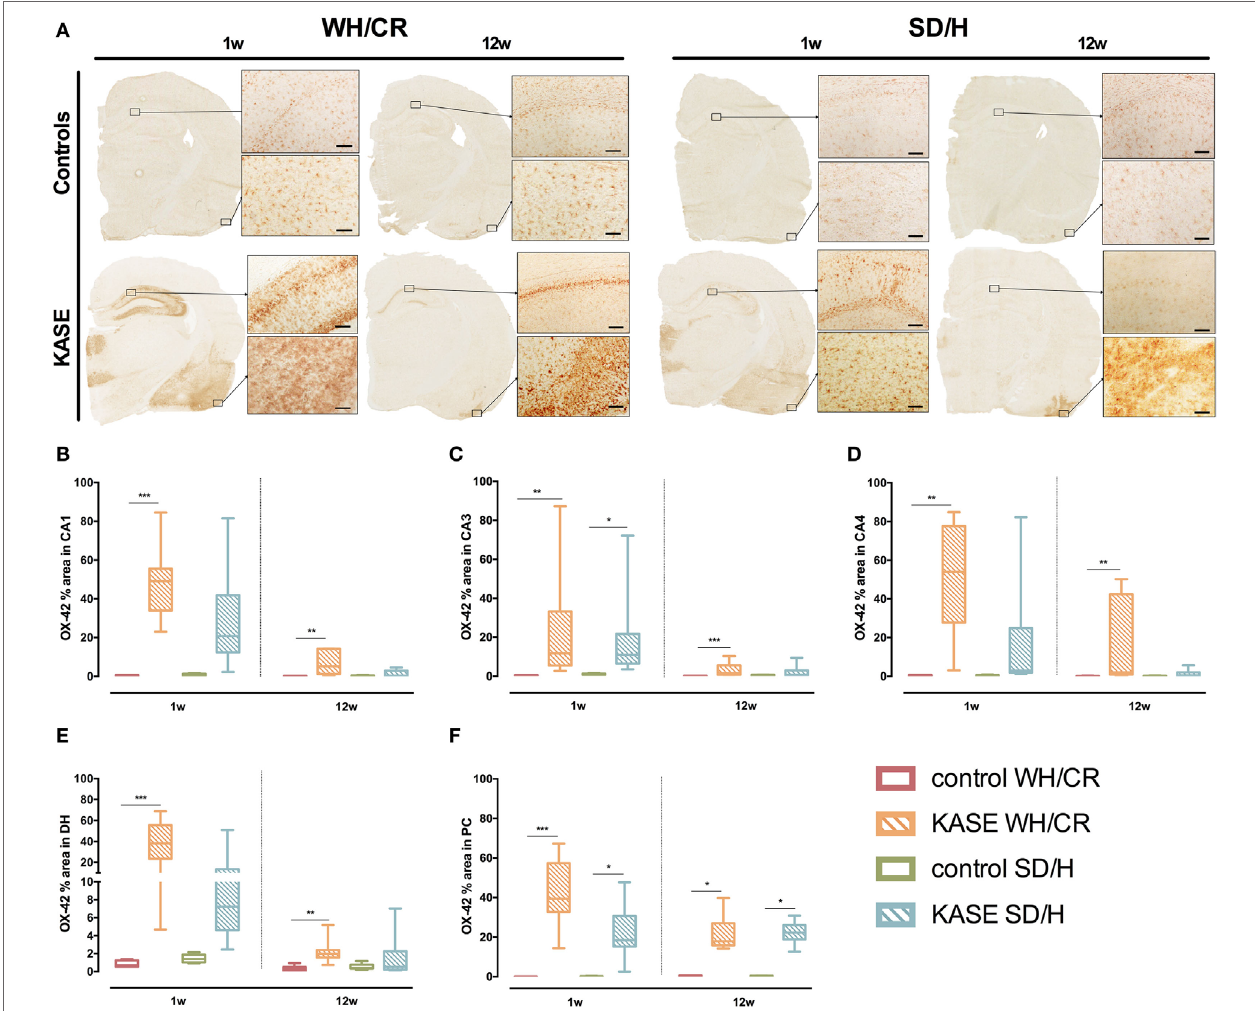
FigUre 5 | Microglial activation in KASE WH/CR and KASE SD/H rats. (a) Representative KASE and control rats 1 and 12 weeks post-status epilepticus (SE). For all investigated regions, a significant difference could be demonstrated between WH/CR controls and KASE rats 1 week post-SE as well as 12 weeks post-SE (B–F) . For the SD/H rats, this was only observed for the CA3 sub-region of the hippocampus and PC 1 week post-SE, while only in PC during the chronic period. Kruskal–Wallis test with post hoc Dunn’s test (B–F) . * p < 0.05, ** p < 0.01, *** p < 0.001. 1 week post-SE: control WH/CR n = 4–5, KASE WH/CR n = 8–10, control SD/H n = 5 and KASE SD/H n = 6; 12 weeks post-SE: control WH/CR n = 5–6, KASE WH/CR n = 7, control SD/H n = 4–6 and KASE SD/H n = 6–8. Insets were taken at 10 × magnification. Scale bar = 100 µm. WH/CR, Wistar Han/Charles River; SD/H, Sprague-Dawley/Harlan; w, week; CA, cornu ammonis; DH, dentate hilus; PC, piriform cortex; KASE, kainic acid-induced status epilepticus